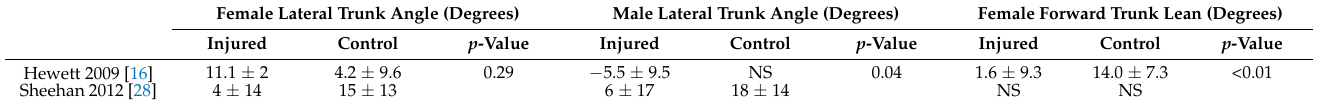
Table 5. Trunk Angle and Motion Values of Studies